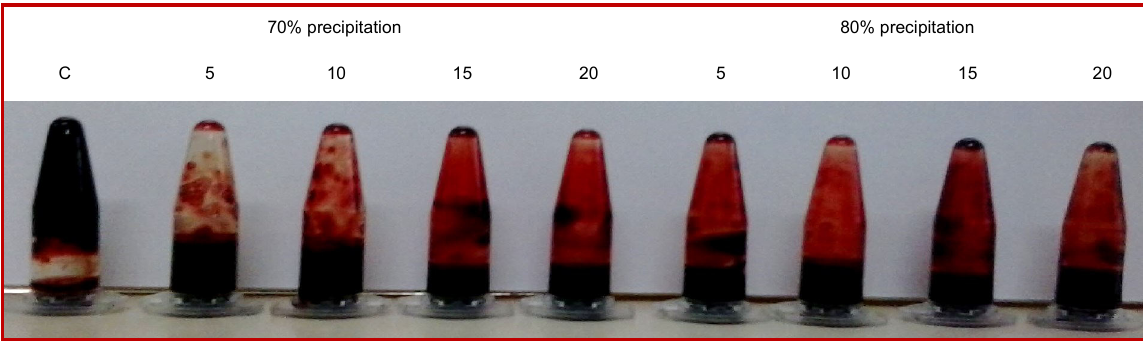
Figure 5: Holmstorm method for Bacillus sp SFN precipitates in production media without shrimp shell (5, 10, 15, 20 µL)